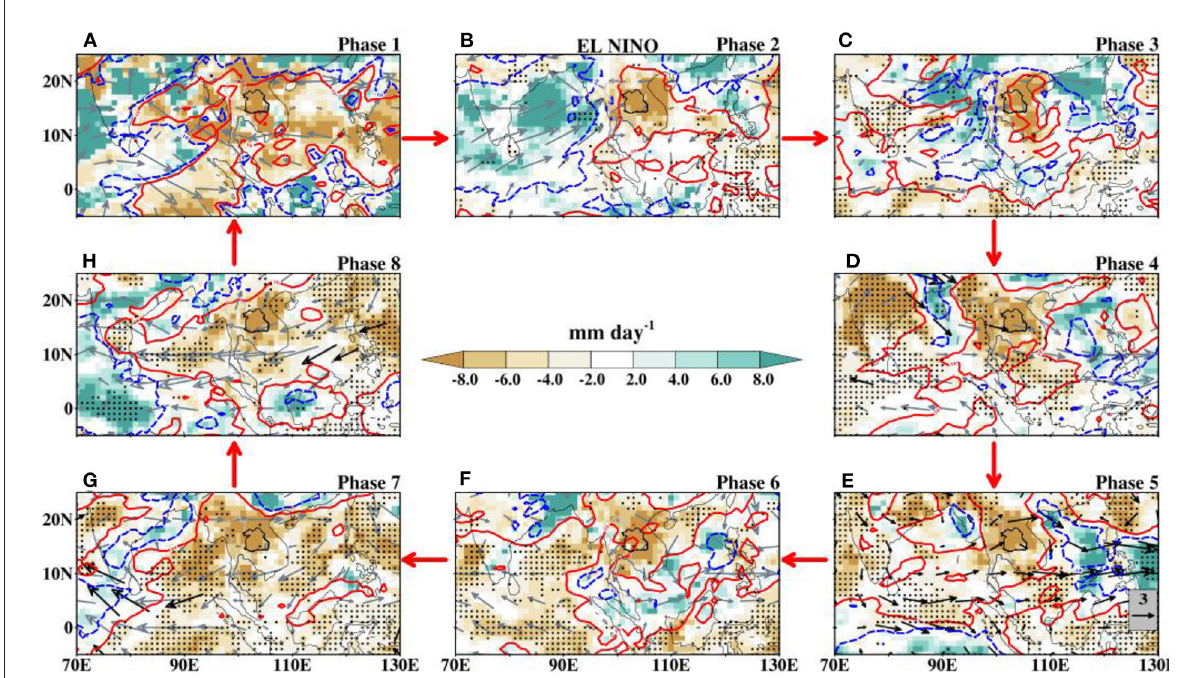
FIGURE12 (A–H) Composite evolution of anomalies of observed dry extreme rainfall events (shaded), OLR (blue and red contours; W m − 2 ), and 850 hPa wind (gray vectors, m s − 1 ) for the May–October season during the period 1997–2014 for El Niño and active BSISO phases. The OLR contour starts at ± 10W m − 2 at an interval of 10W m − 2 . Only the significant vector anomalies are shown with solid black arrows while the statistically significant rainfall anomalies are indicated with dots. The significance statistic is at the 95% confidence level.